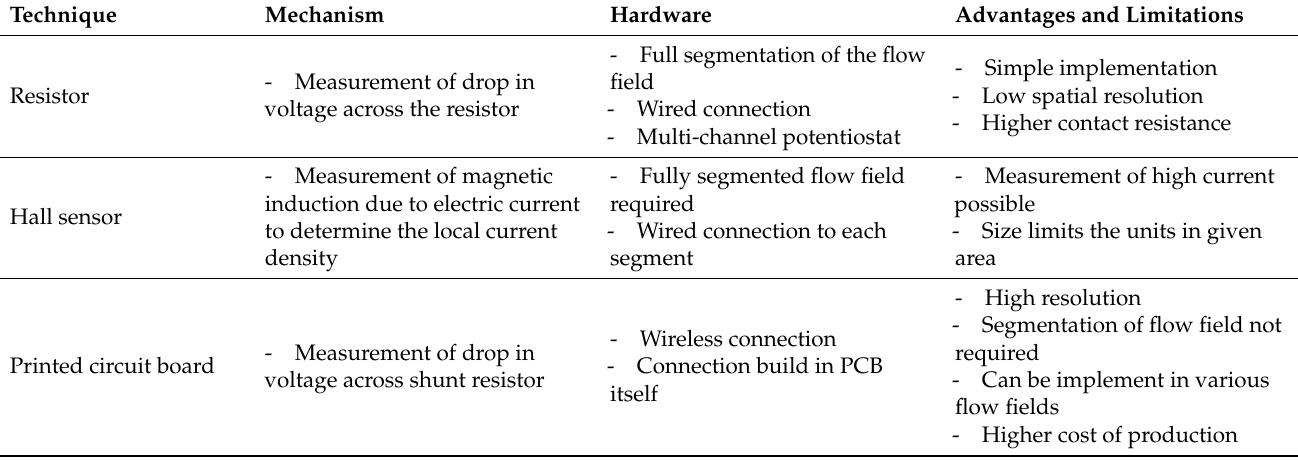
Table 3. Measurement technique for local current or voltage